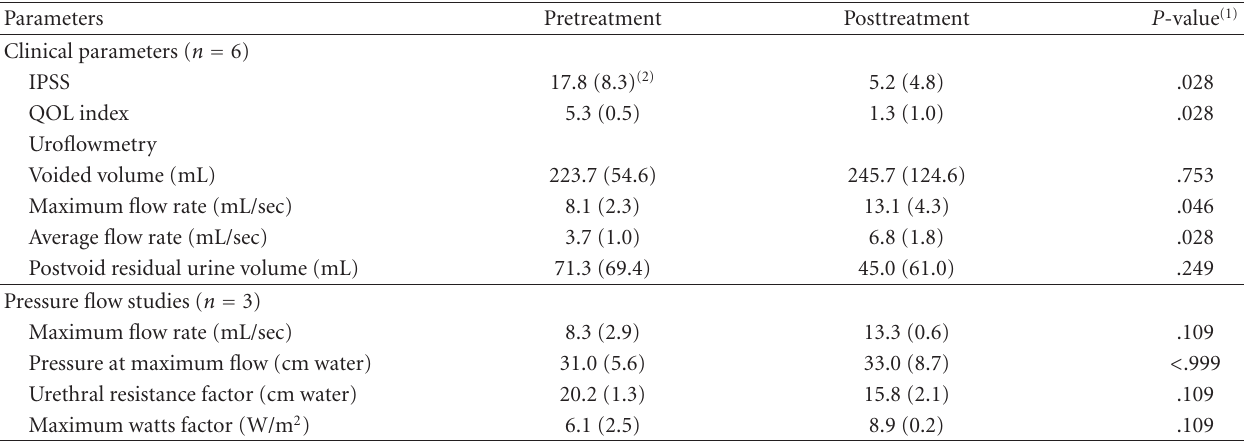
Table 3: Change in parameters after distigmine bromide treatment in patients without bladder outlet obstruction.